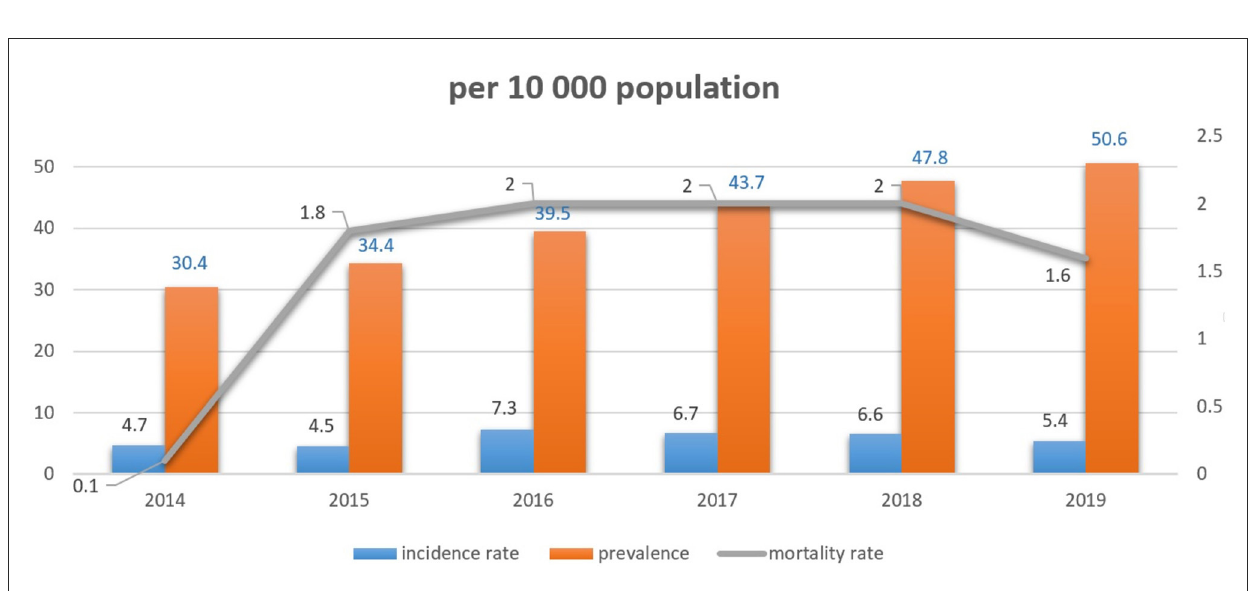
FIGURE2 Incidence, prevalence and mortality rates of patients with breast